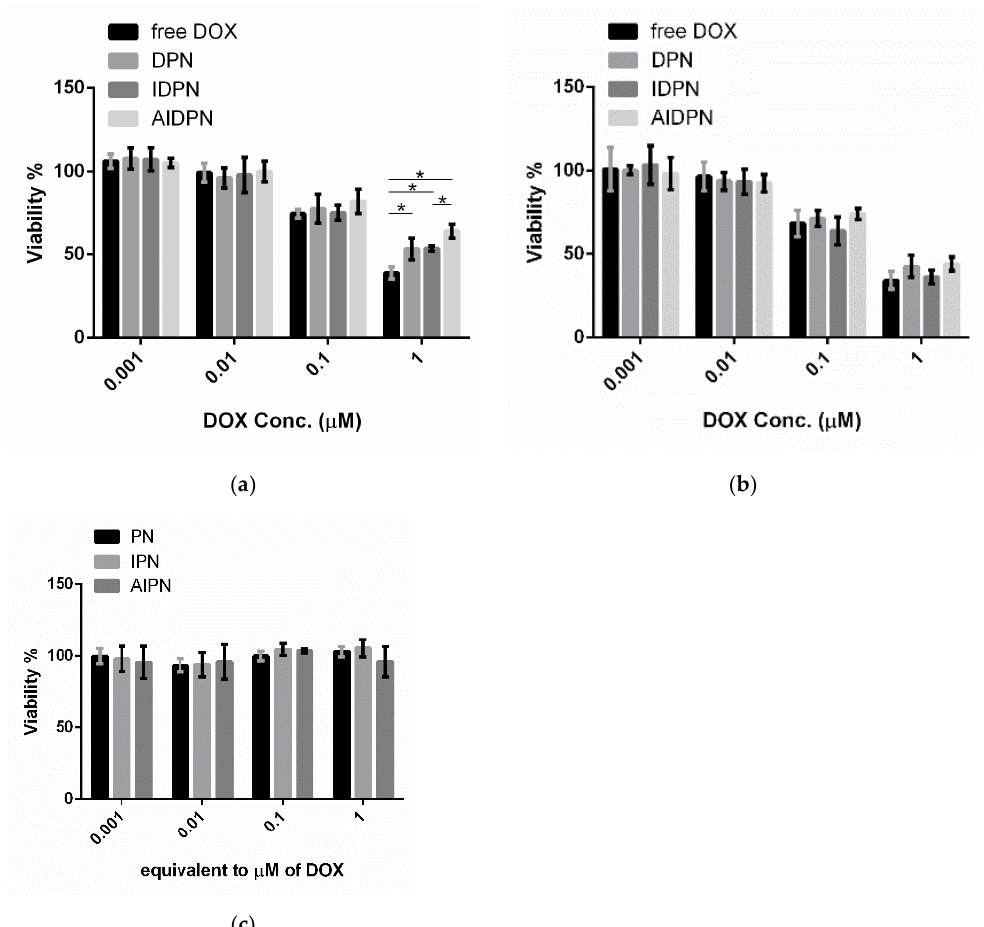
Figure 5. Cytotoxicity of free DOX, DPN, IDPN, and AIDPN with different concentrations for ( a ) 24 h and ( b ) 48 h incubation, and ( c ) blank nanoparticles for 48 h incubation in A549. * indicates comparison of two group, p < 0.05.